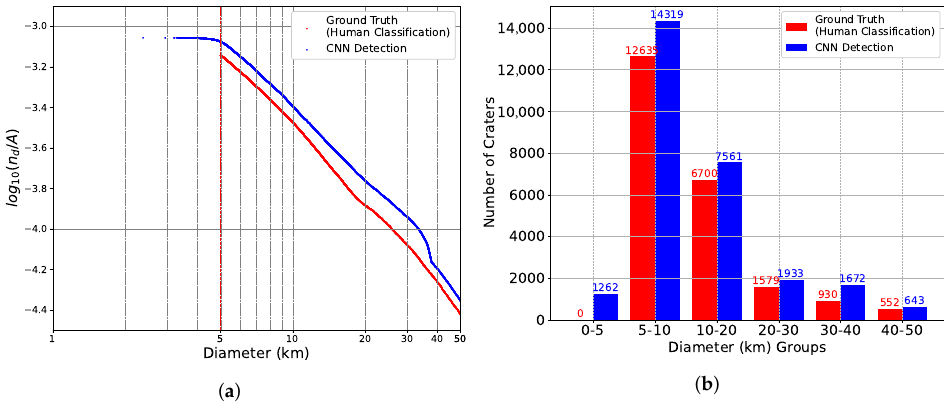
Figure 11. Cumulative size-frequency distribution (CSFD) ( a ) and size statistics ( b ) of the craters detected by CNN (blue) and obtained by human classification (red) with a diameter between 1 and 50 km.